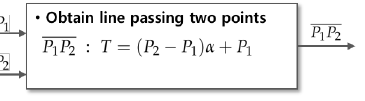
Figure A1. Obtaining a line equation passing two given